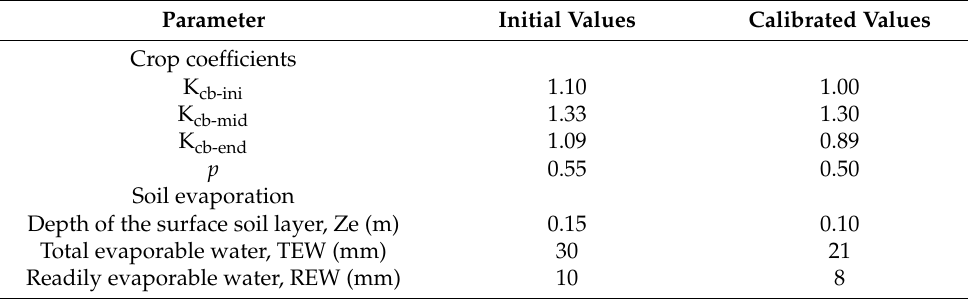
Table 3. Initial and calibrated values of crop and soil parameters in SIMDualKc.